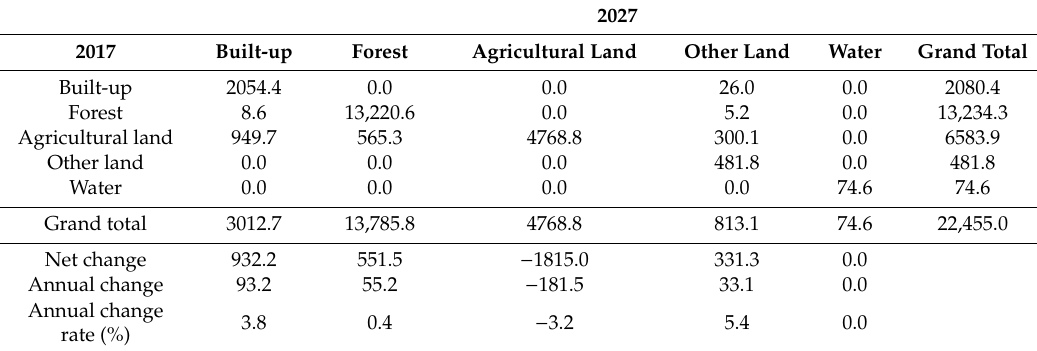
Table 10. Land use and land cover change matrix (ha), 2017–2027.